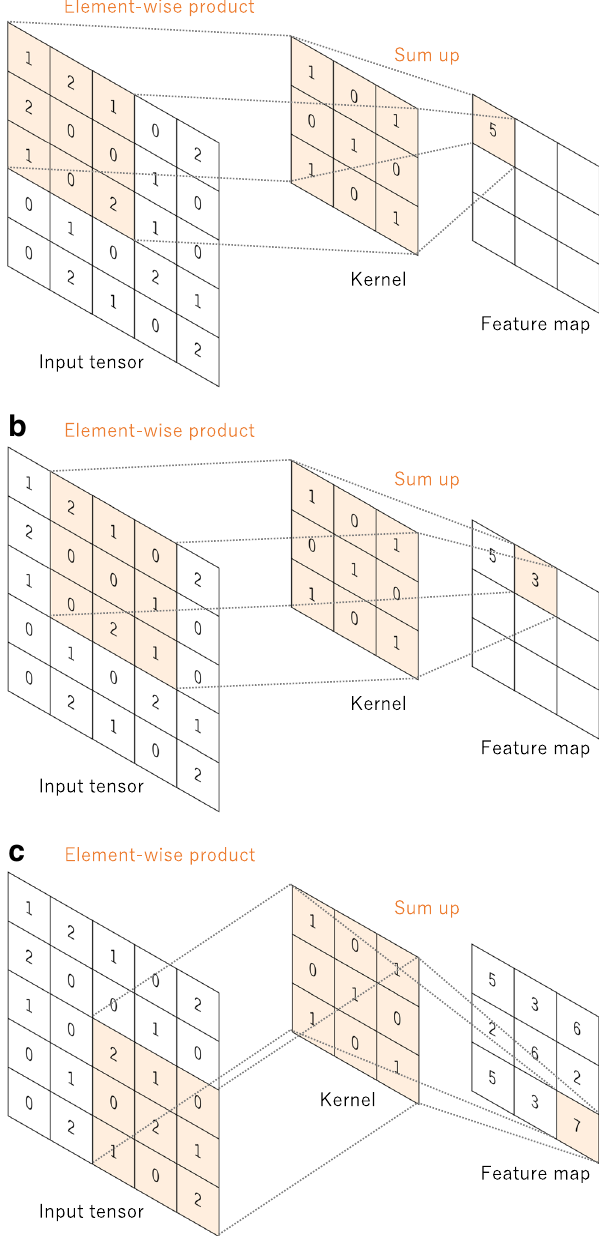
Fig.3 a – c An example ofconvolution operation with a kernel size of 3 × 3,nopadding,anda strideof1.A kernel isapplied across the inputtensor, and an element-wise product between each element of the kernel and the input tensor is calculated at each location and summed to obtain the output value in the corresponding position of the output tensor, called a feature map. d Examples of how kernels in convolution layers extract features from an input tensor are shown. Multiple kernels work as differ- ent feature extractors, such as a horizontal edge detector (top), a vertical edge detector (middle), and an outline detector (bottom). Note that the left image is an input, those in the middle are kernels, and those in the right are output feature